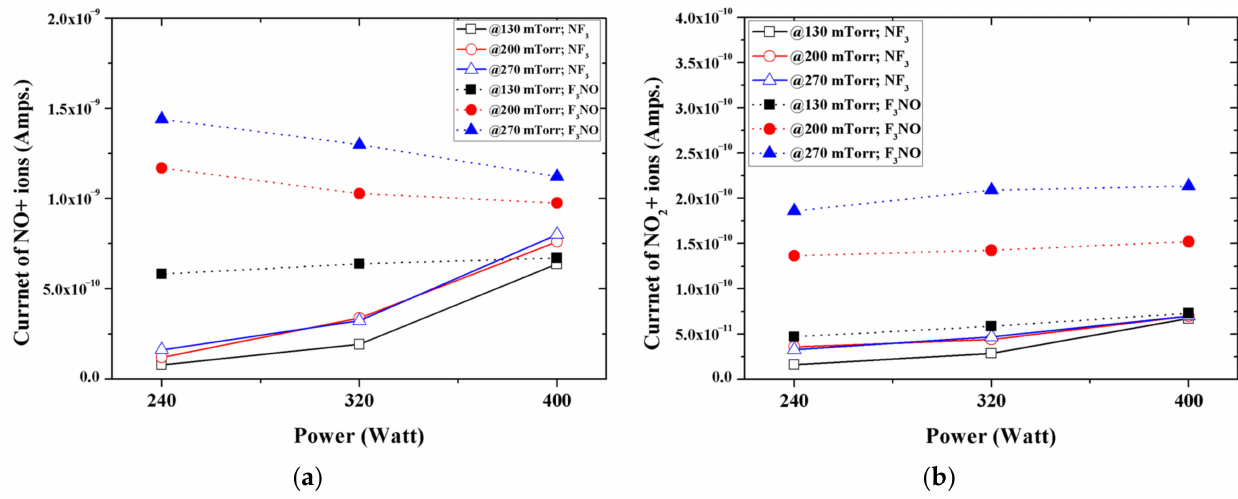
Figure 6. Intensity: of ( a ) NO+ ions; ( b ) NO 2 + ions during plasma silicon oxide etching as functions of the input power for various working